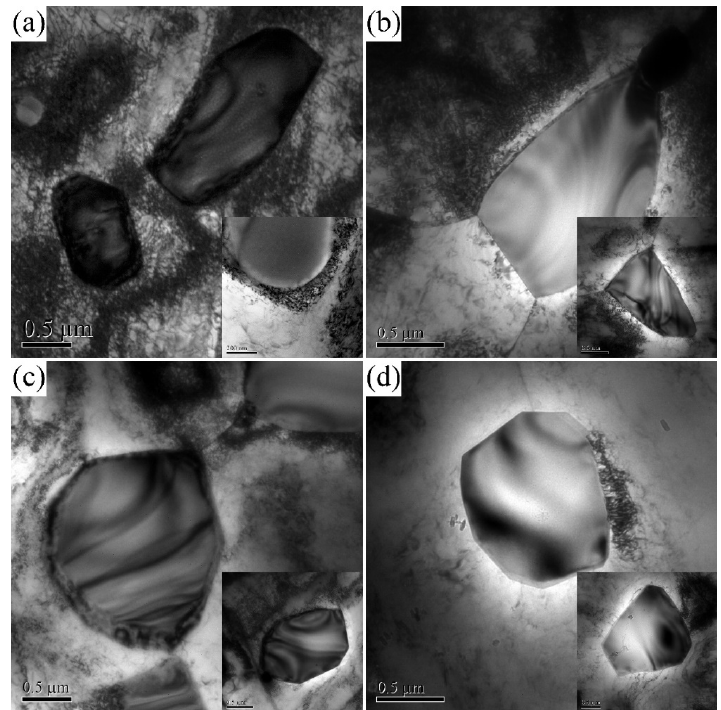
Figure 5. The TEM microstructures of the HEA after tensile tests at different temperatures. ( a ) Room temperature, ( b ) 700 °C, ( c ) 800 °C and ( d ) 900 °C.